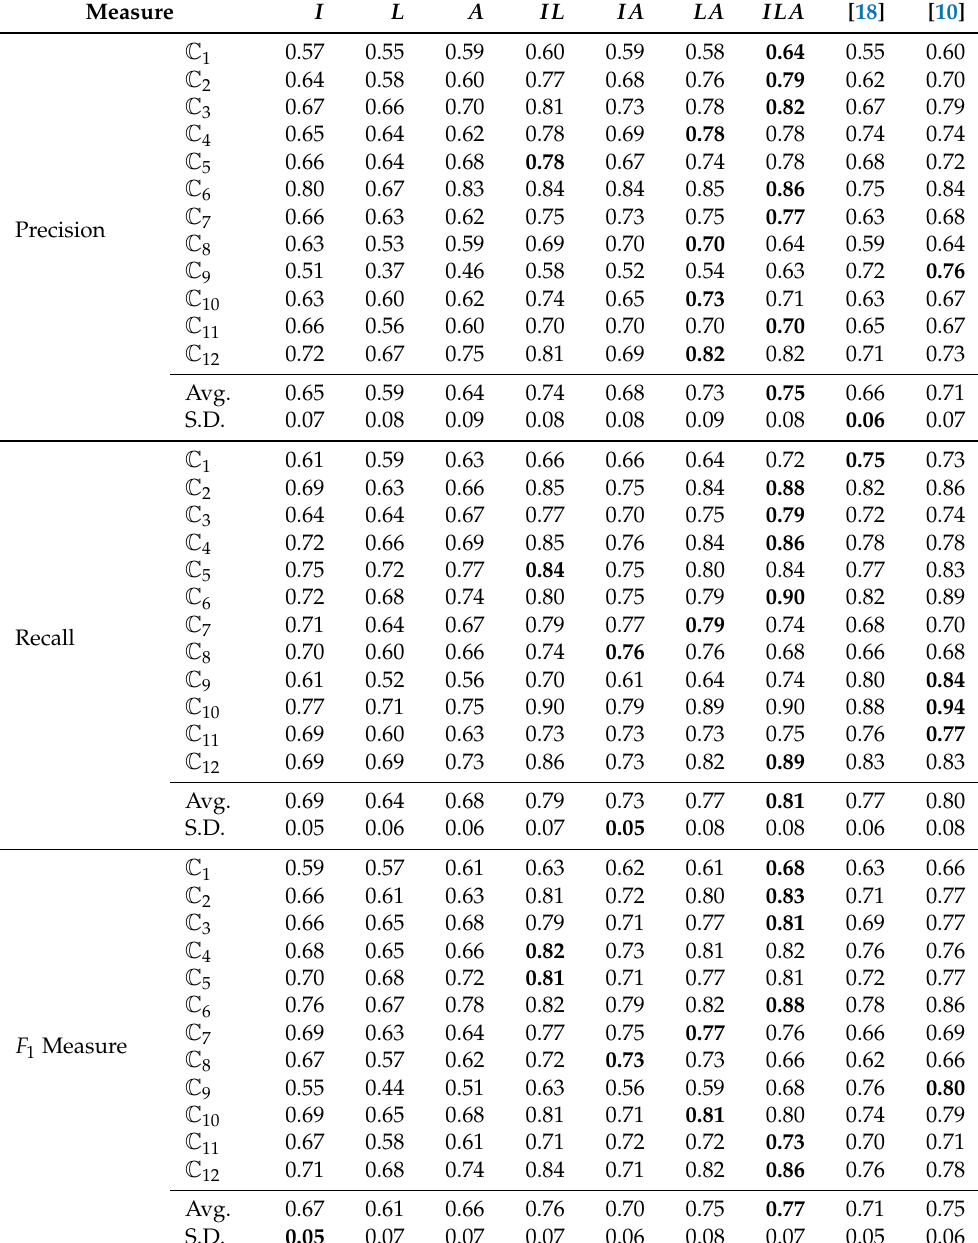
Table 3. Experimental results for the accuracy of the plot structure